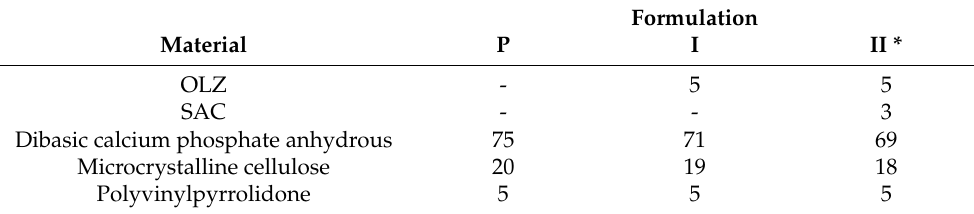
Table 1. Composition of formulations (% w / w ) used in the